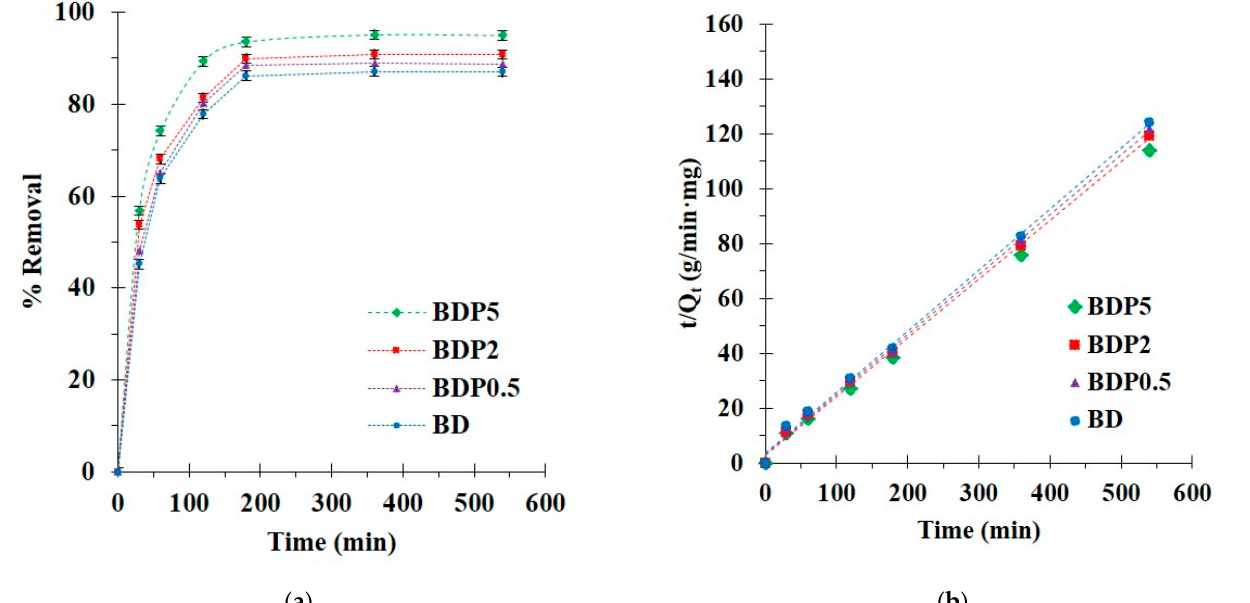
Figure 7. ( a ) Influence of contact time on paraquat adsorption; ( b ) pseudo-second-order kinetics of paraquat adsorption (conditions: 5 g/L of adsorbent dosage, 25 mg/L of PQ initial concentration, pH of 8, and temperature at 303 K).